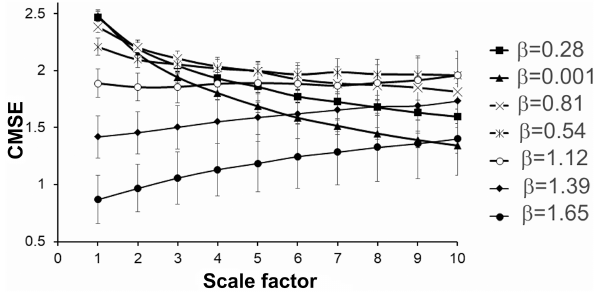
Figure 5. (a) Logarithms of, normed to the span of window, abso- lute values of IDT calculated for different lengths (circles – 34020, squares – 20000, triangles – 10000, diamonds – 5000 data) of win- dows of simulated noise data sets with different spectral indexes. (b) Averages of IDT values calculated for 100 data windows normed to the span of window simulated noise data sets with different spec- tral